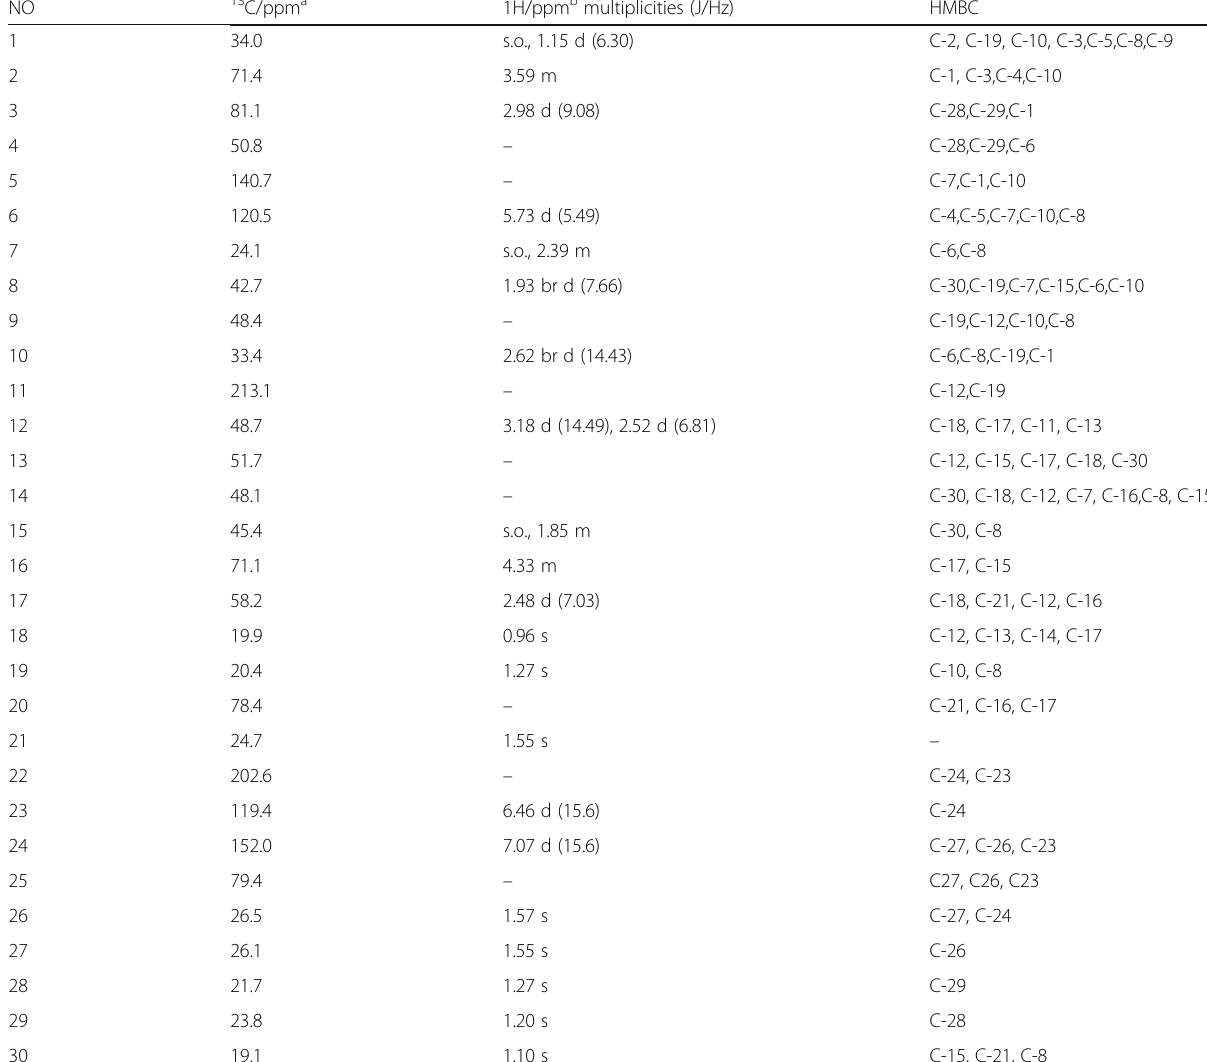
Table 3 NMR spectroscopic data of compound